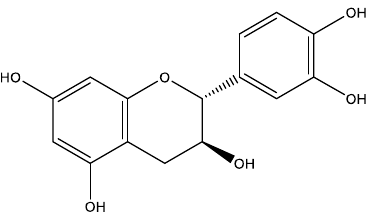
Figure 1. The chemical structure of